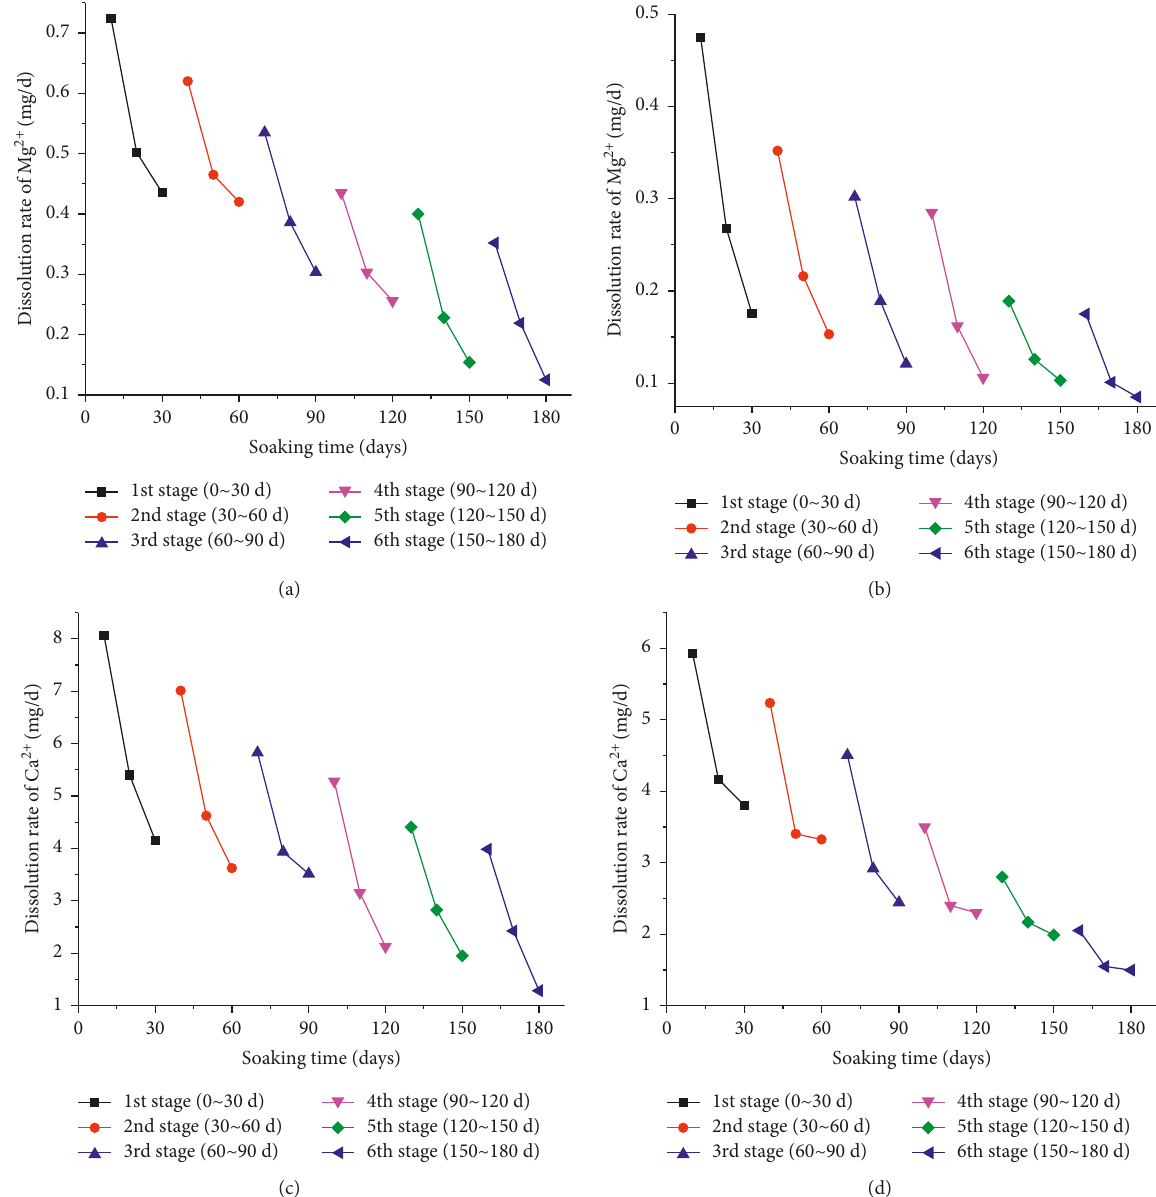
Figure 10: Cation dissolution rate diagram of soaking solution. Dissolution rate of Mg 2+ in H Dissolution rate of Ca 2+ in H 2 SO 4 solution at (c) pH